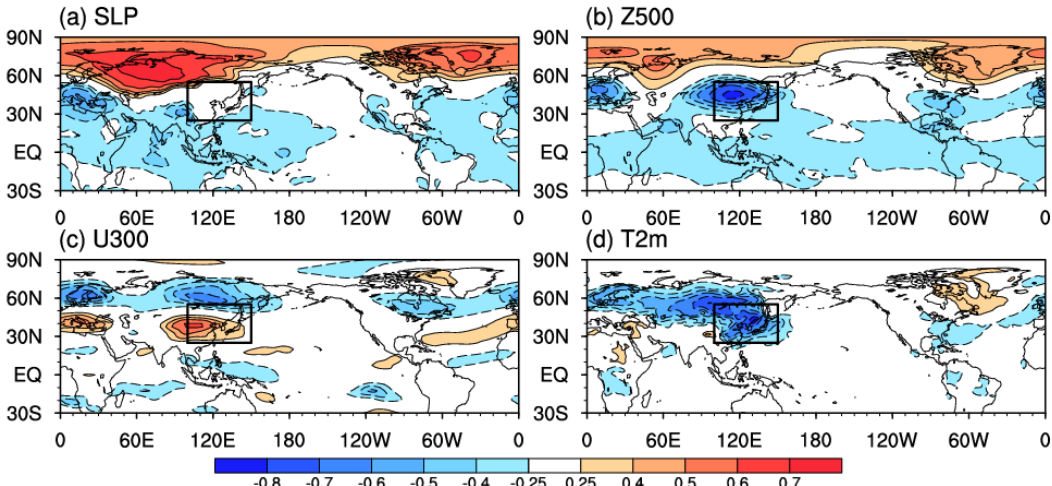
Figure 5. Maps of correlation coefficients between NCD index and winter ( a ) SLP, ( b ) Z500, ( c ) U300, and ( d ) T2m during 1956–2015. The black rectangle-shaped box indicates East Asia (100–150° E, 25–55° N). Shaded values are significant, exceeding 95% confidence level based on Student’s t -test.